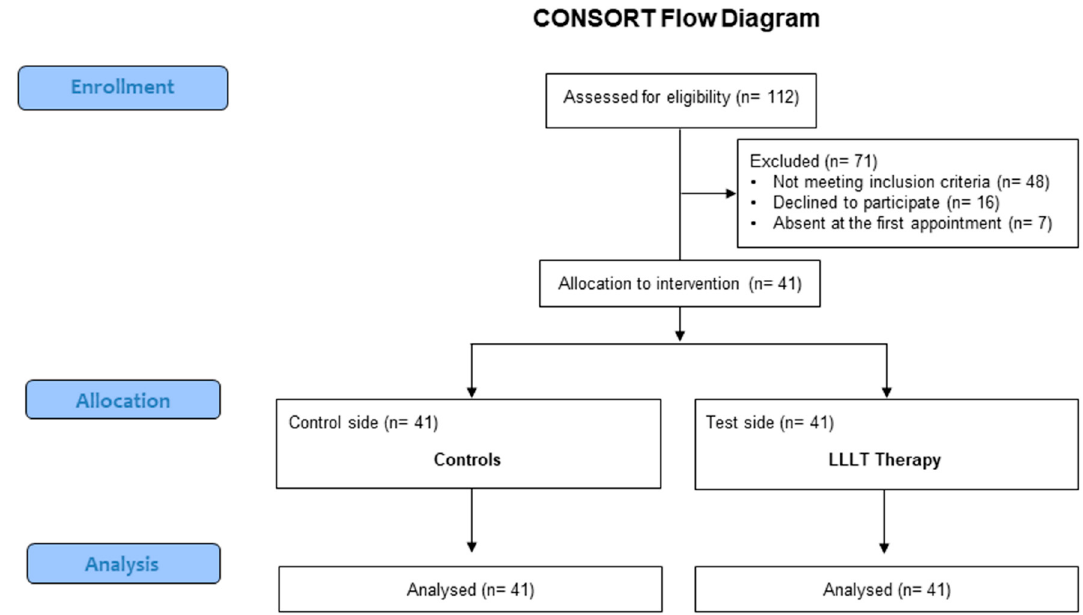
Figure 1. Flowchart of the study.